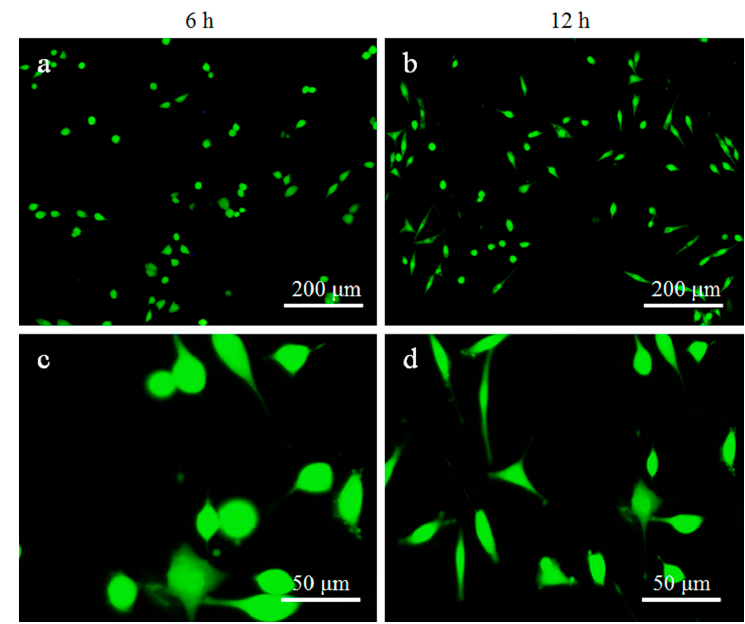
Figure 9. Viability analysis of MG63 cells after cultivation on TTCP scaffold for 6 and 12 h. ( a, b ) Low magnifications images and ( c, d ) high magnification images.